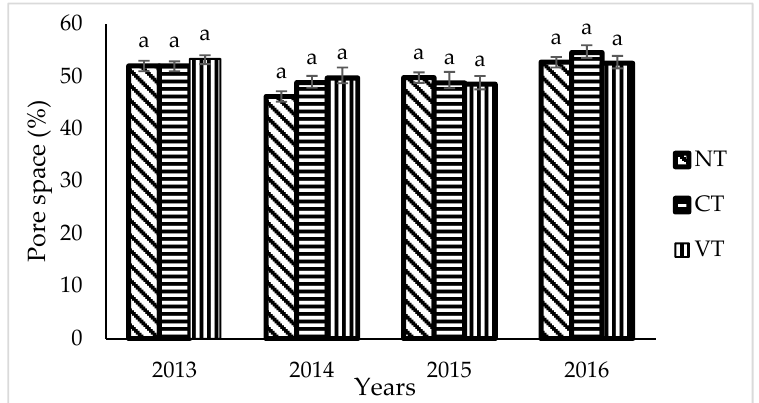
Figure 5. Pore space (P) in the surface layer from 0 to 5 cm through the years for the different tillage systems. Mean values with the same letter in the same year are not significantly different (Tukey α ≤ 0.05). Bars on top of treatment are the standard error.